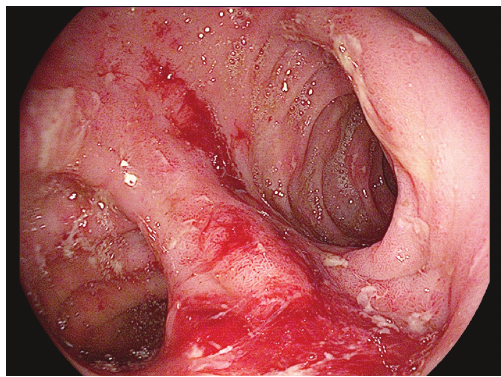
Figure 1: Clinical picture of palpable purpura involvement of bilateral lower extremities.